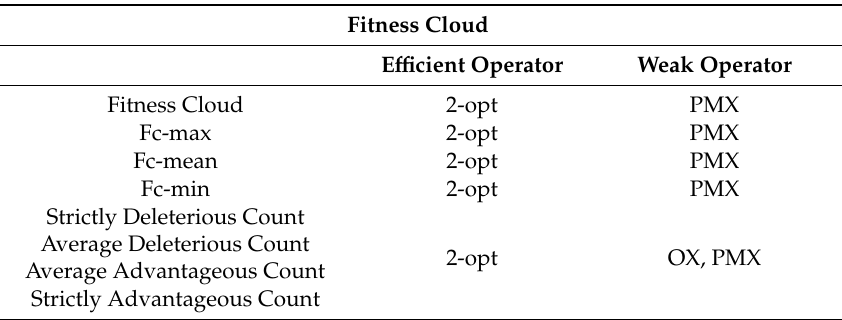
Table 10. Fitness cloud